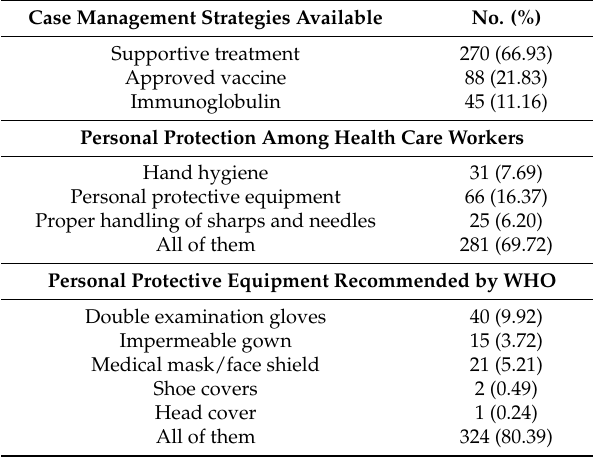
Table 3. Respondents’ opinion towards personal protection and management strategies.